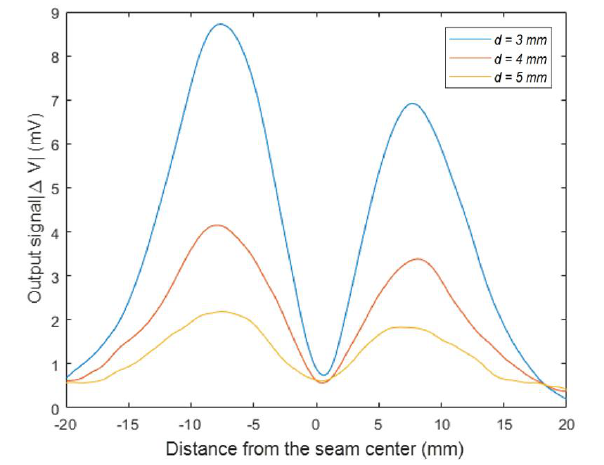
Figure 13. The sensor output signal with a variable thickness of the cover panel.